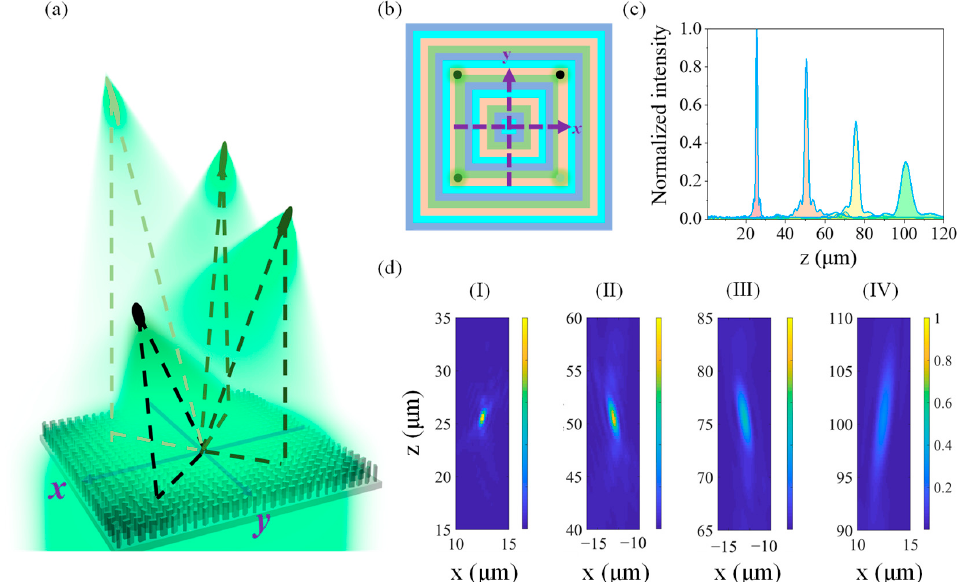
Figure 6. A metalens with multiple focal points in space. ( a ) Schematic of a multifocal metalens and its focal points. ( b ) Regional distributions of the four sublenses and the projection of the focal points on the horizontal plane. ( c ) Intensity distributions of the focal fields for a multifocal metalens along the respective optical axes. ( d ) Intensity distributions of the focal fields for a multifocal metalens in the xz plane ( y = 12.5 μ m). (I) x ∈ [10, 15] and z ∈ [15, 35]. (II) x ∈ [ − 15, − 10] and z ∈ [40, 60]. Intensity distributions in the xz plane ( y = − 12.5 μ m). (III) x ∈ [ − 15, − 10] and z ∈ [65, 85]. (IV) x ∈ [10, 15] and z ∈ [90, 110].